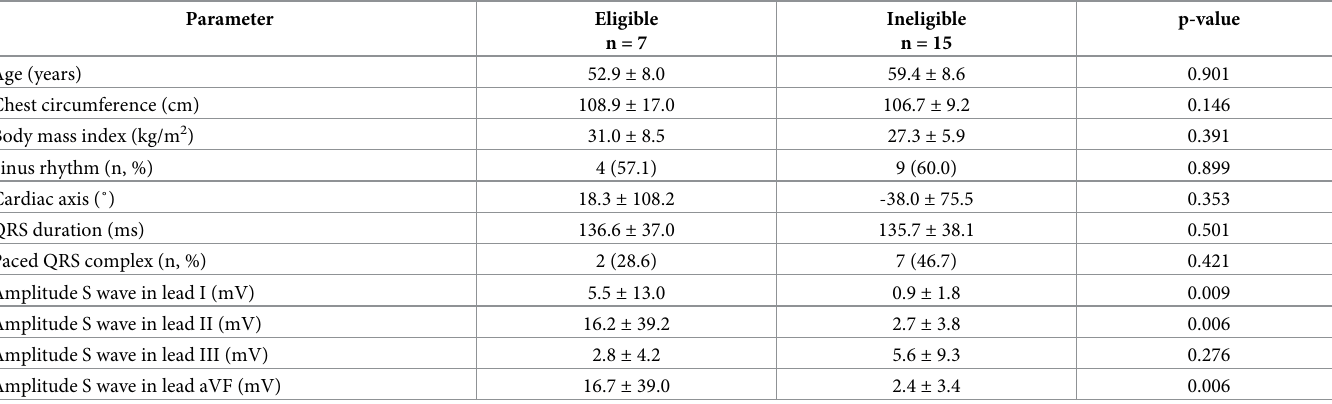
Table 3. Comparison of recorded parameters between patients eligible and ineligible for S-ICD implantation after implantation of left ventricular assist